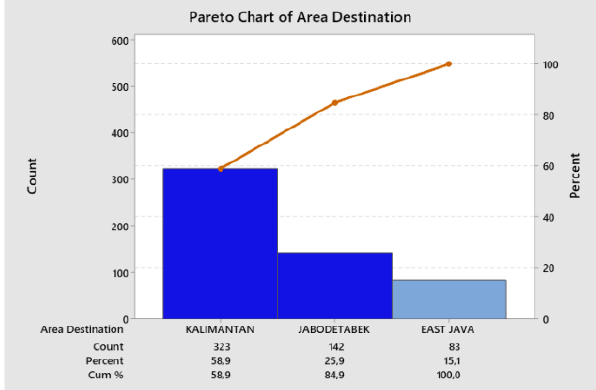
Figure 2: Pareto Chart of Late SCPOD Submission based on Area